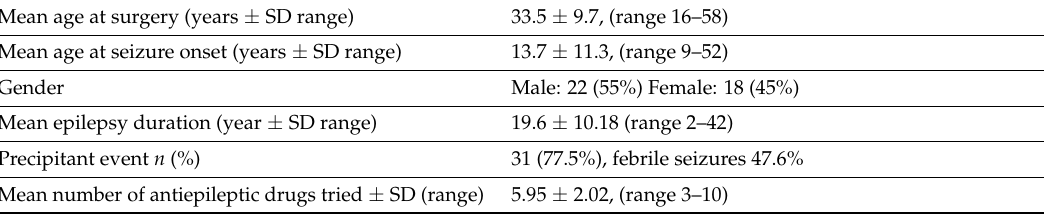
Table 1. Demographic, clinical and surgical cohort characteristics (40